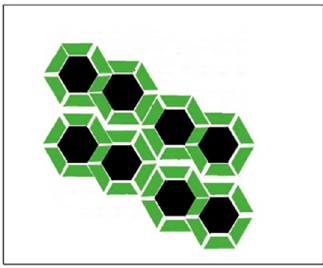
Figure 9. Aggregate of rigid clusters at X g ∼ = X M cr = 0.154 where M = 11. Gramicidin dimers (black hexagons) may be regularly distributed into superlattices in the aggregated rigid